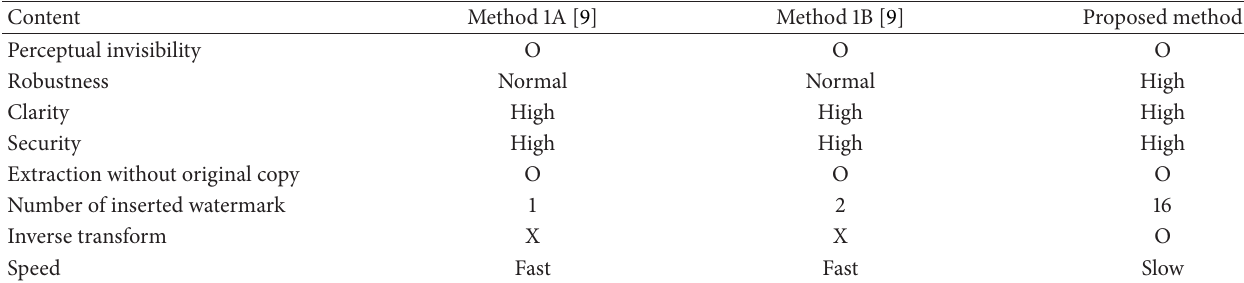
Table 1: Comparison with previous